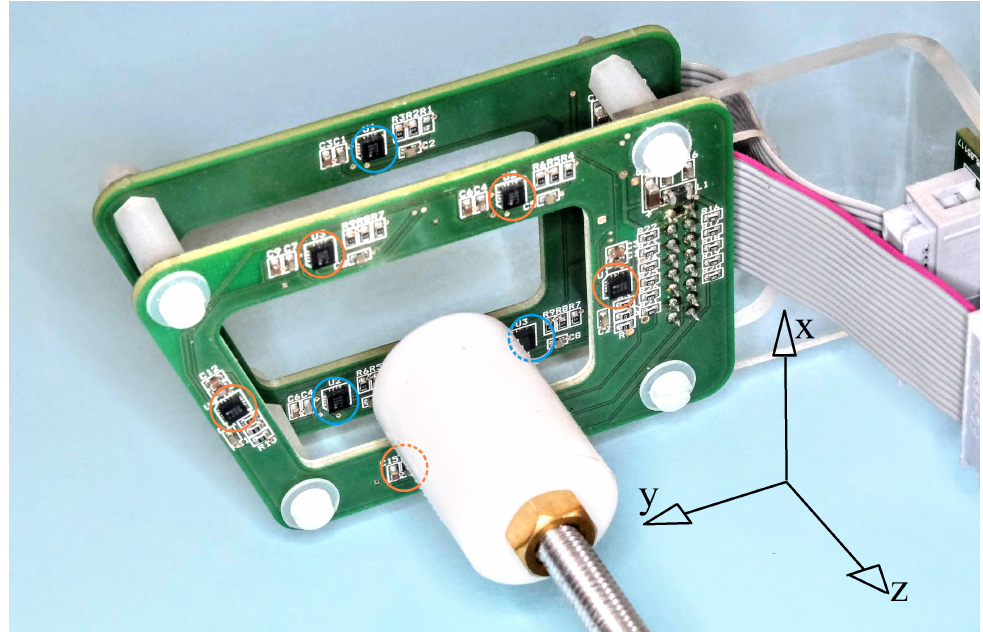
Figure 1. The sensor array contains 8 sensors distributed on two parallel PCBs (three of them, highlighted with blue circles are a z = 0 and other five (orange circles) at z = 16.6 mm). The system is designed for eye-tracking purposes. A 20 mm diameter cylinder is used to emulate eye motion. It hosts the magnetic source (target), which performs either circular or helix